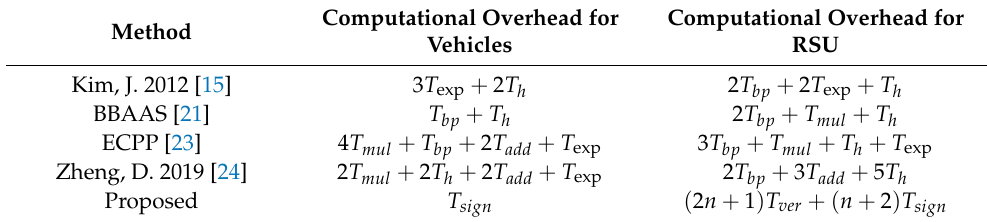
Table 2. Comparison of computational